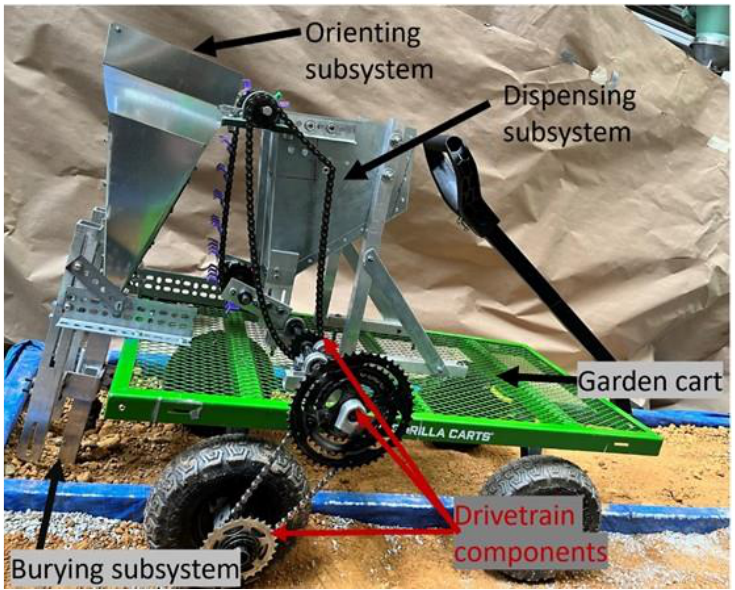
Figure 10. Prototype of the onion